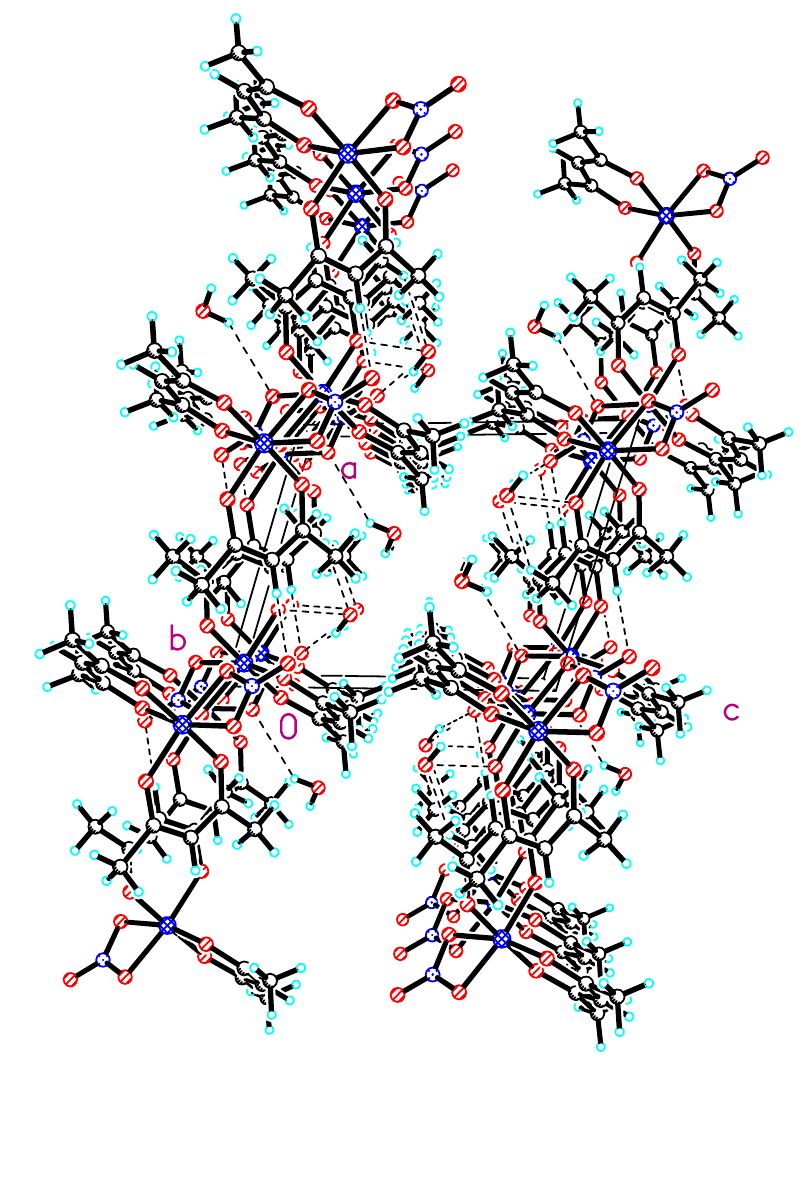
Figure 4. The crystal packing for 2 viewed along the b -axis, showing intermolecular O- H···O hydrogen bonds as dashed